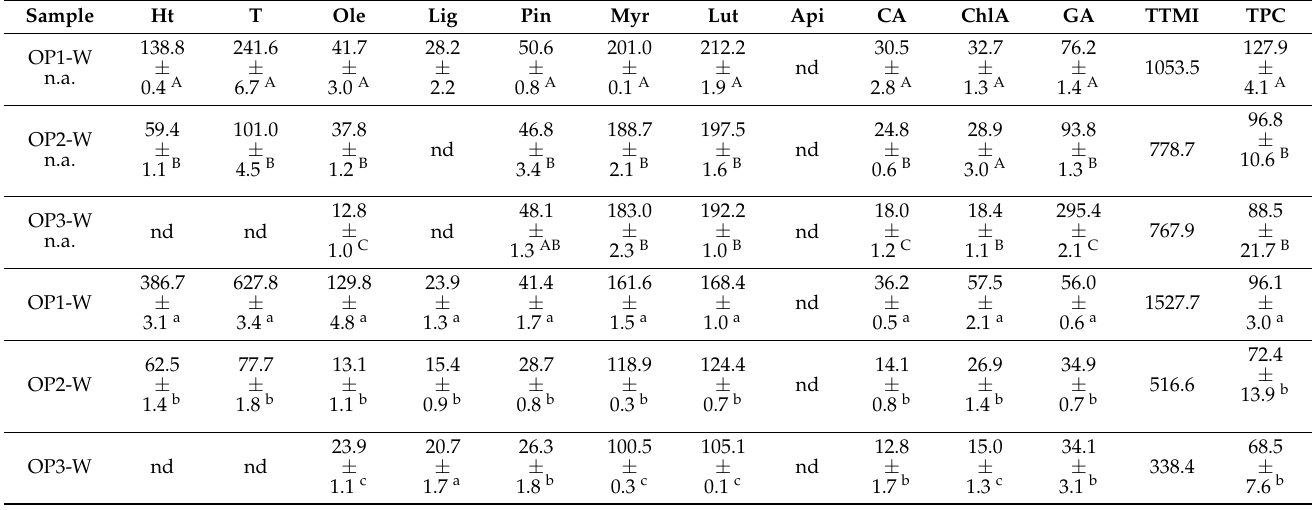
Table 2. Phenolic composition (total µ g in the dialyzed samples) and TPC (mg of GAE/g extract) of the digested OP batches. See Table 1 for abbreviations.